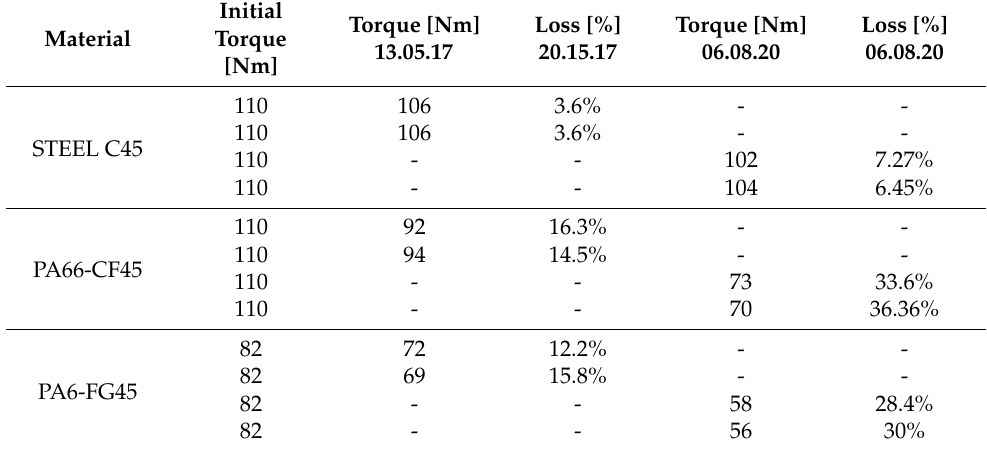
Table 3. Loss of torque